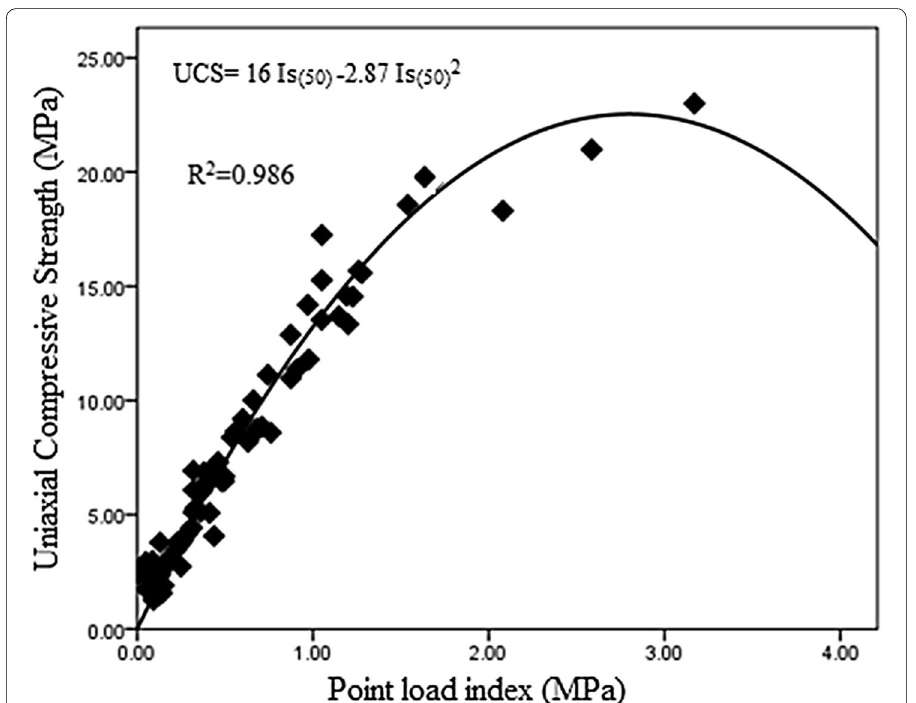
Fig. 1 The relation between I s(50) and